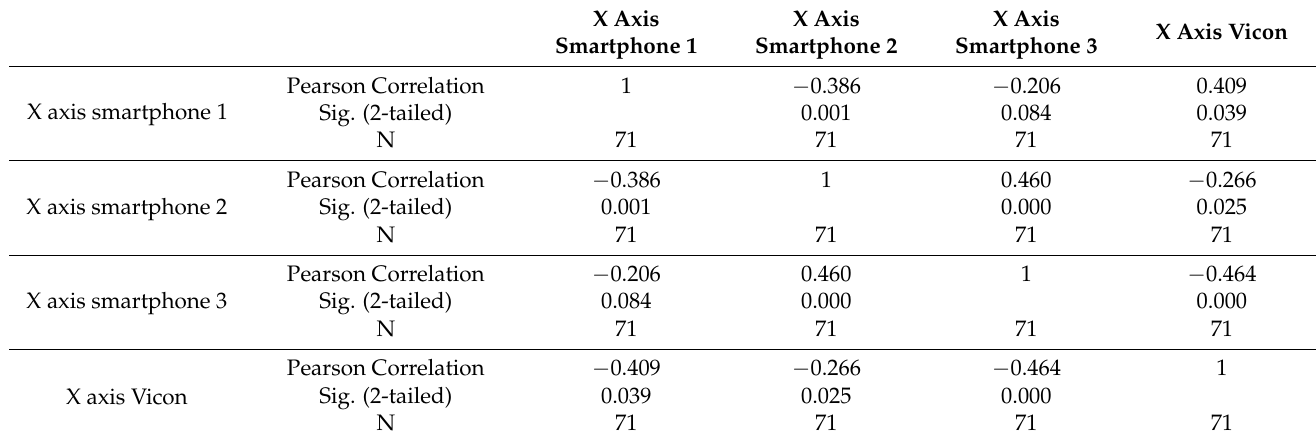
Table 3. Pearson r correlations from each device linear acceleration’s data on the X axis.